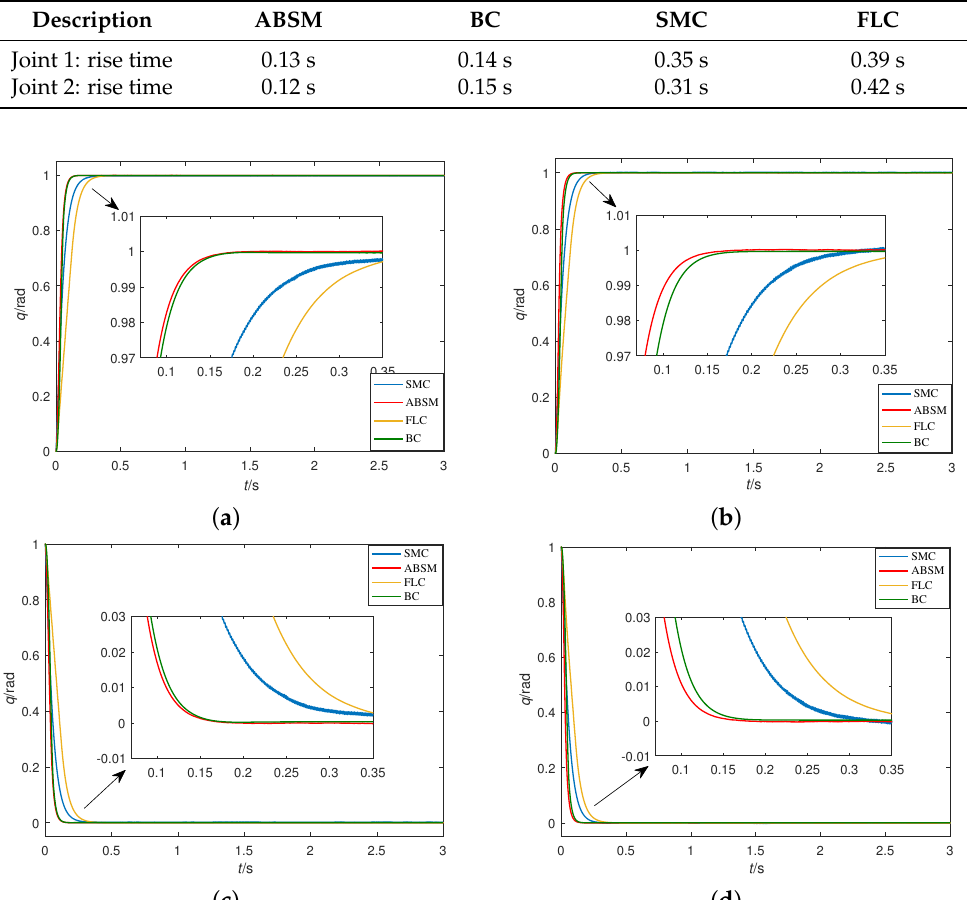
Figure 5. Position tracking curve and tracking error curve of two joints under ABSM, BC, SMC, and FLC. ( a ) Position tracking curve of Joint 1. ( b ) Position tracking curve of Joint 2. ( c ) Tracking error curve of Joint 1. ( d ) Tracking error curve of Joint